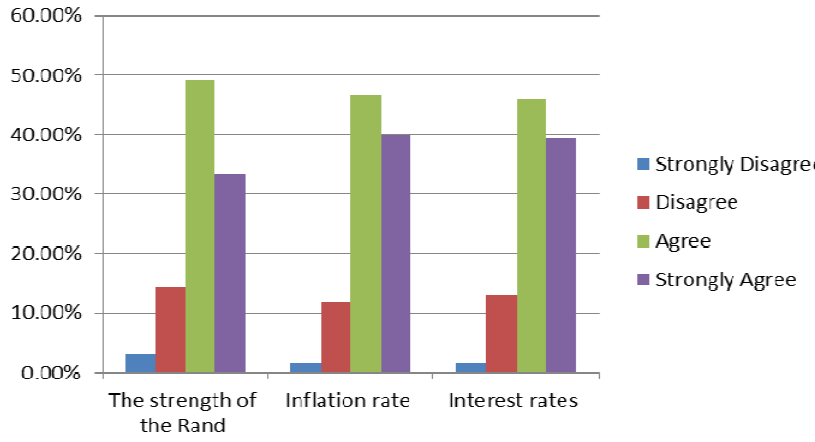
Fig. 3. Participants response with regards to macroeconomic factors